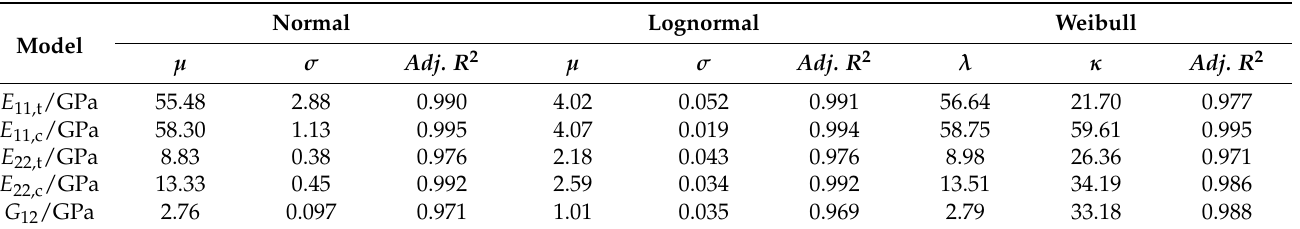
Table 9. Values of the three statistical distribution parameters for the stiffness properties of H-GFRPs in a humid and hot